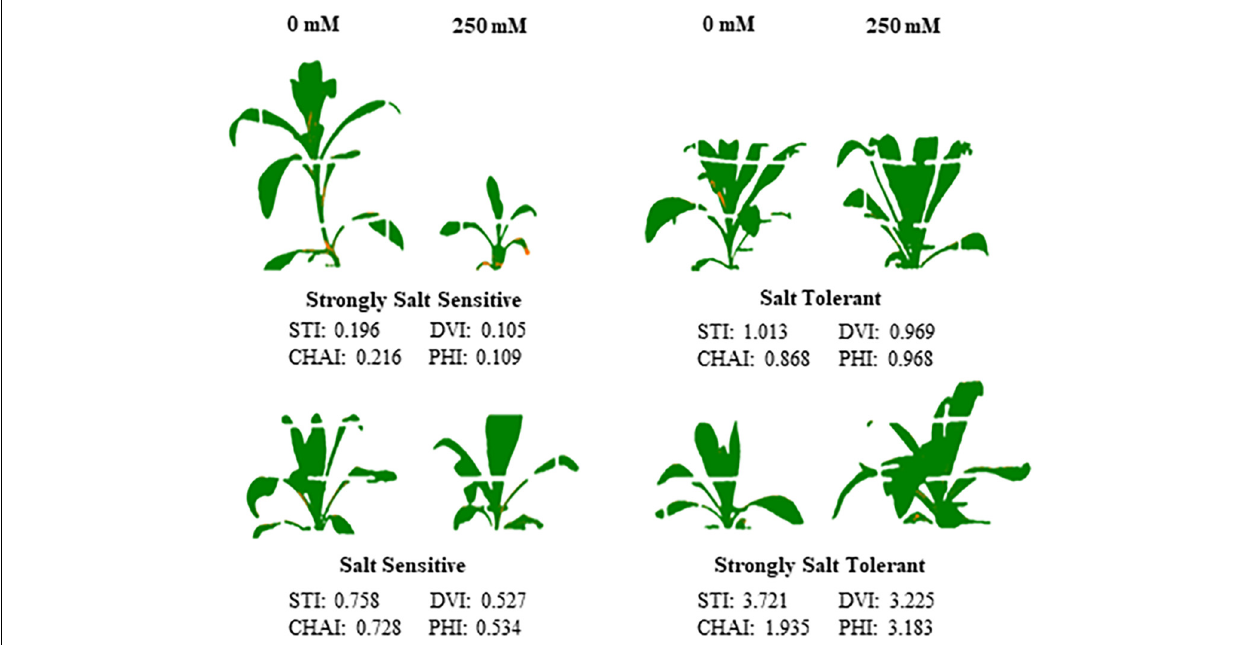
FIGURE 7 | Performance of the four classes of safflower genotypes under control and salt (NaCl) treatments. Processed images and dry biomass salt tolerance index (STI) of genotypes under control (0 mM) and salt (250 mM) treatments, representing the four classes of genotypes; strongly salt sensitive (STI < 0.5), salt sensitive (STI 0.5–0.8), salt tolerant (0.8–1.1), and strongly salt tolerant ( > 1.1). TABLE 1 | Performance of safflower genotypes grown under sodic field conditions compared to performance in glasshouse. Variety Emergence (plants/m 2